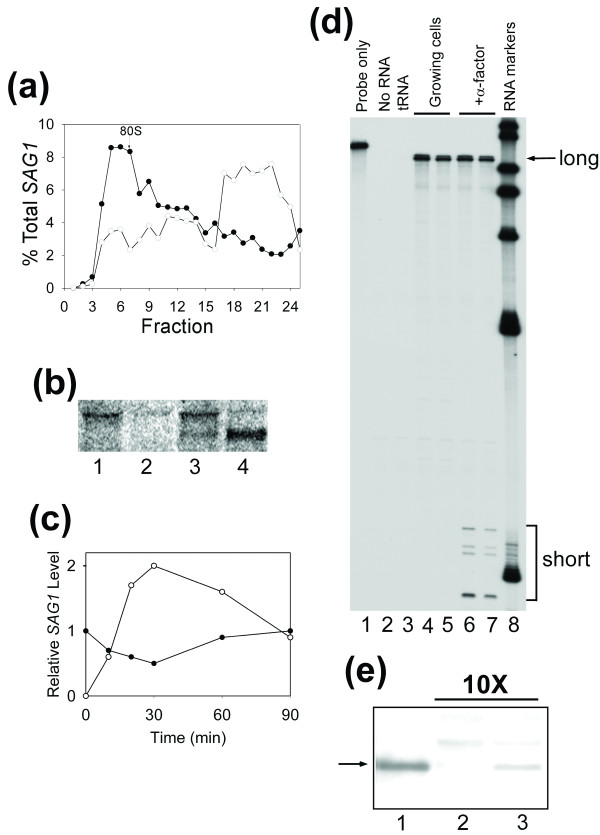
Structure of the 5' leader of the SAG1 transcript regulates its translation. (a) Distribution of SAG1 mRNA across polysome gradients in growing cells (filled circles) or cells treated with a-factor for 30 min (open circles). Cell lysates [3] were loaded onto 7-47% sucrose gradients and spun for 1.5 hours in a SW40 rotor at 39,000 rpm at 4°C. Levels of SAG1 transcript in each gradient fraction were determined by real-time polymerase chain reaction (QPCR) and the signal in each fraction was divided by the sum of the signals in all fractions. The top of the gradient is to the left and the position of the 80S monosome is marked with the arrow. (b) Northern blot analysis of SAG1 RNA from growing cells (lanes 1 and 2) or from cells after 45 min of a-factor treatment (lanes 3 and 4). Equal cell equivalents of RNA from pooled sucrose gradient fractions 1-14 (lanes 1 and 3) or pooled fractions 15-25 (lanes 2 and 4) were analyzed. (c) Relative levels of SAG1 mRNA at different time points after treatment with a-factor. Total RNA was isolated from cells treated with a-factor for the indicated times and cDNA was produced with reverse transcription by priming with oligo(dT)25. SAG1 transcript levels were determined by QPCRusing either primers recognizing both transcripts or primers specific for the long transcript. Closed circles show the values for the long form and the open circles represent calculated values for the short SAG1 transcripts, computed as the differences between the values for both transcripts and those for the long transcript. The curves are normalized to a value of 1.0 for the long transcript at zero time of treatment. (d) RNase protection assay showing two forms of SAG1 : lane 1, probe only; lane 2, no RNA; lane 3, tRNA control; lanes 4 and 5, 50 µg total RNA from growing cells; lanes 6 and 7, 50 µg total RNA from cells treated for 30 min with a-factor; and lane 8, RNA markers. The antisense RNA probe was prepared from cloned genomic sequence and contained 55 nucleotides of open reading frame, 484 nucleotides of 5' leader, and 92 nucleotides of noncomplementary sequence. Independent RNA preparations were used in lanes 4-7. Locations of the protected probes corresponding to SAG1 long 5' leader (539 nucleotides) and short 5' leader (95 nucleotides) are indicated. (e) Western blot analysis of protein extracts from growing cells was performed to determine the relative levels of His3-HA protein from yeast strains transformed with reporter constructs containing the ADH1 promoter and SAG1 short 5' leader (lane 1), SAG1 long 5' leader (lane 3), or the empty vector (lane 2). The arrow indicates location of the His3-HA protein. As indicated in the figure, lanes 2 and 3 had 10 times more protein loaded than did lane 1.